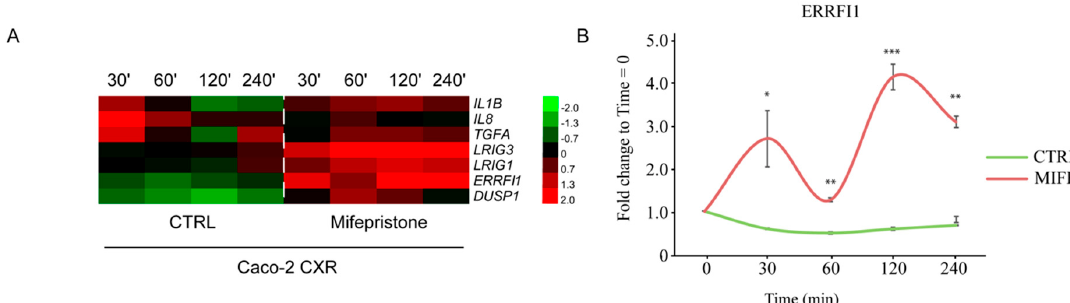
Figure 5. Inhibition of glucocorticoid receptor reactivates negative feedback loops in cetuximab-resistant Caco-2 cell line. ( A ) Heatmap showing gene expression of EGFR positive (IL-1B, IL-8 and TGFA) and negative (LRIG3, LRIG1, ERRFI1 and DUSP1) feedback loops, in Caco-2 cetuximab resistant (CXR) cells pretreated with and without mifepristone (MIFE, 5 µM) for 10 min and stimulated with a combination of cetuximab (CTX, 2 µg/mL) and EGF (20 ng/mL) at the indicated time points (30, 60, 120 and 240 min). ( B ) ERRFI1 gene expression profile over time following treatments described in A. Statistical test of triplicated data was determined by multiple t-test, using the Holm-Sidak method, with alpha = 5%. Each row was analyzed individually, without assuming a consistent SD. *** p < 0.0005, ** p < 0.01, * p < 0.05.